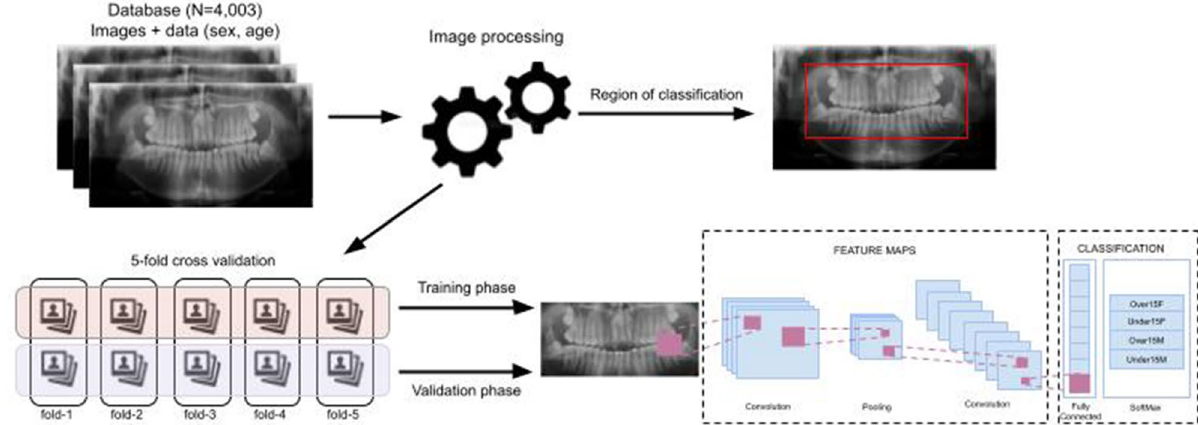
Figure 1. Model structured for this study showing the workflow from sampling, image processing, annotation, cross-validation, training/validation to